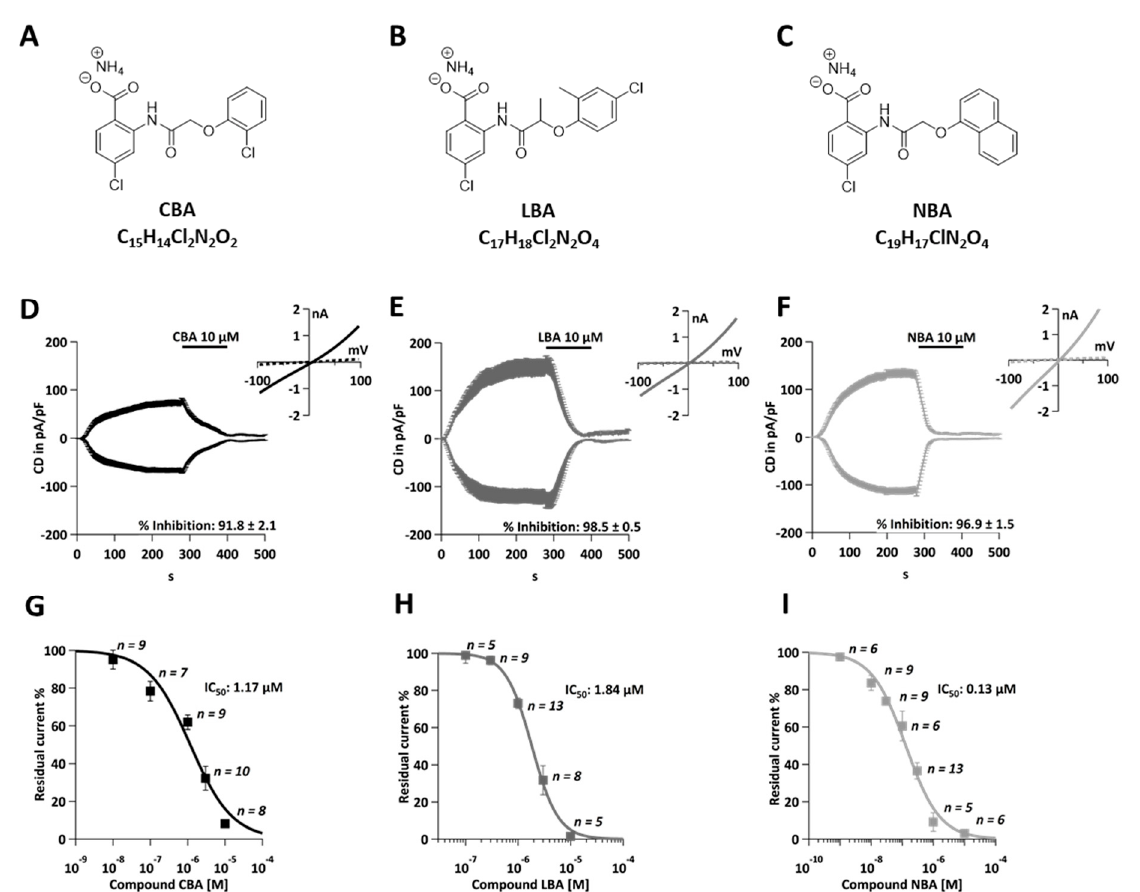
Figure 1. Novel TRPM4 inhibitors block TRPM4 currents in HCT116 cells. ( A ) Chemical structure of CBA. ( B ) Chemical structure of LBA. ( C ) Chemical structure of NBA. ( D ) Whole-cell patch clamp data from HCT116. Currents were evoked with 10 µM Ca 2+ in the patch pipe tt e and normalized to cell size. Current density (CD), displayed as mean +/ − SEM, is plotted versus time and 10 µM CBA was applied from 280–400 s. Inset: IV curves at t = 276 s and t = 396 s ( n = 8). ( E ) Same as ( D ) for LBA ( n = 5). ( F ) Same as ( D ) for NBA ( n = 6). ( G ) Average TRPM4 CD +/ − SEM was plo tt ed against CBA concen- trations ( n = 9 for 0.01 µM, n = 7 for 0.1 µM, n = 9 for 1 µM, n = 10 for 3 µM, and n = 8 for 10 µM). Dose–response curve was fitted with a Hill equation and IC 50 value was 1.84 µM. ( H ) Average TRPM4 CD +/ − SEM was plo tt ed against LBA concen- trations ( n = 5 for 0.1 µM, n = 9 for 0.3 µM, n = 13 for 1 µM, n = 8 for 3 µM, and n = 5 for 10 µM). Dose–response curve was fitted with a Hill equation and IC 50 value was 1.84 µM. ( I ) Average TRPM4 CD +/ − SEM was plo tt ed against NBA concen- trations ( n = 6 for 0.001 µM, n = 9 0.01 µM, n = 9 for 0.03 µM, n = 6 for 0.1 µM, n = 13 for 0.3 µM, n = 5 for 1 µM, and n = 6 for 10 µM). Dose–response curve was fitted with a Hill equation and IC 50 value was 1.84 µM.